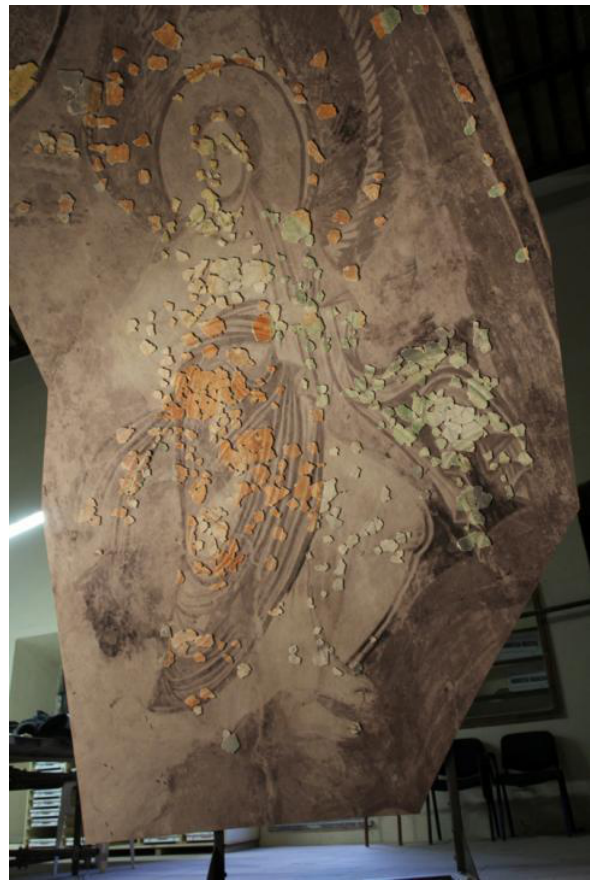
Figure 21. A part of the model where is possible to notice the perfect conformity between the little piece of the destroyed frescos and the achieved support. (Courtesy of ISCR and Werner Matthias